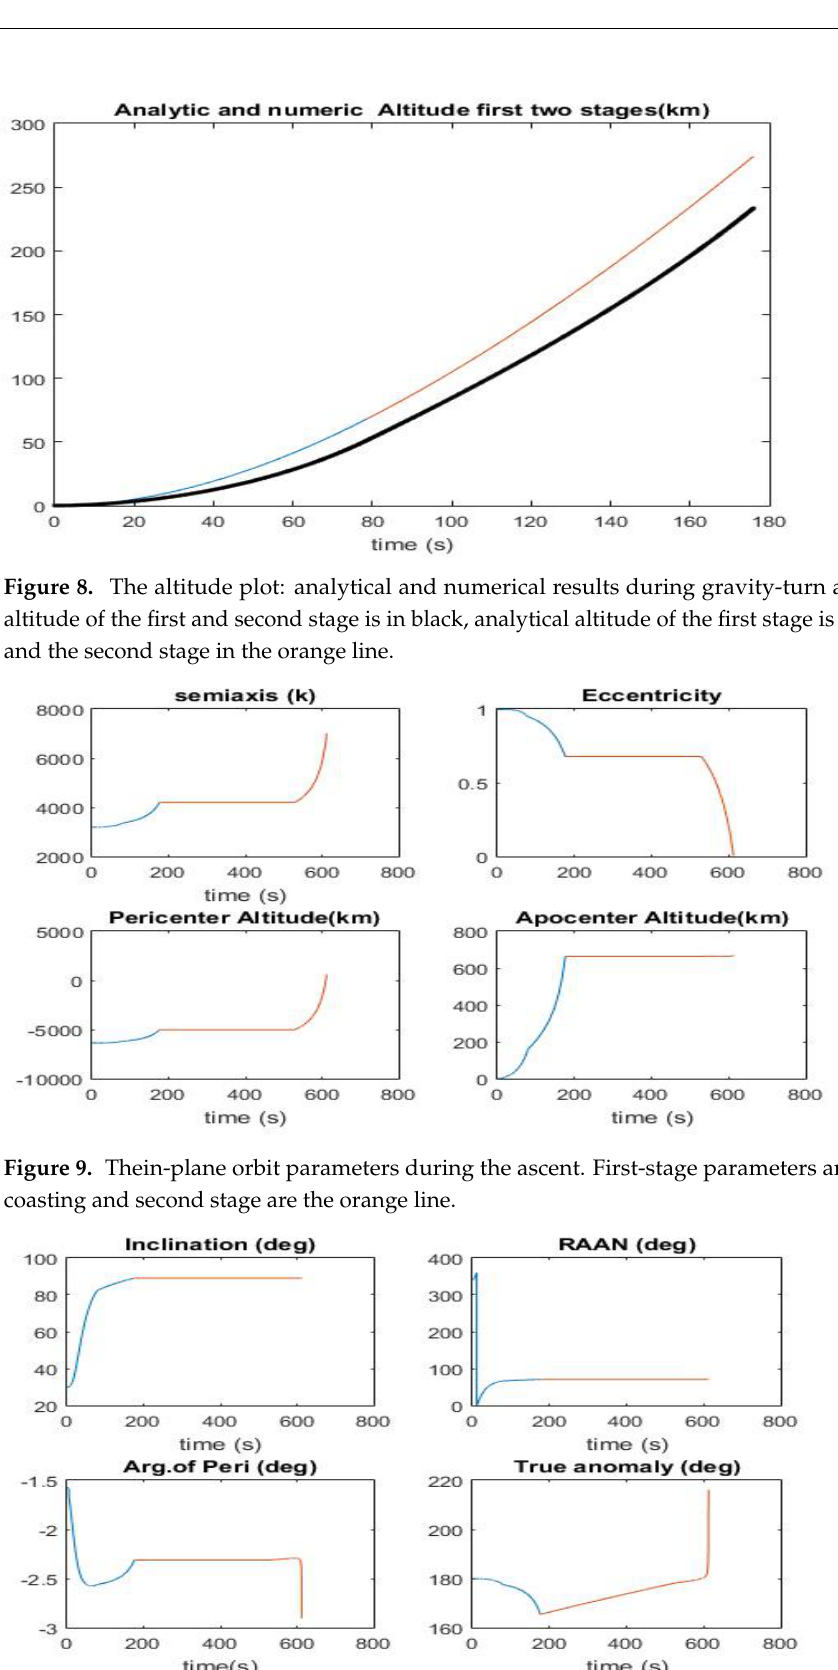
Figure 10. Out–of-plane orbit parameters during the ascent. First-stage parameters are in the blue line; coasting and second stage are in the orange